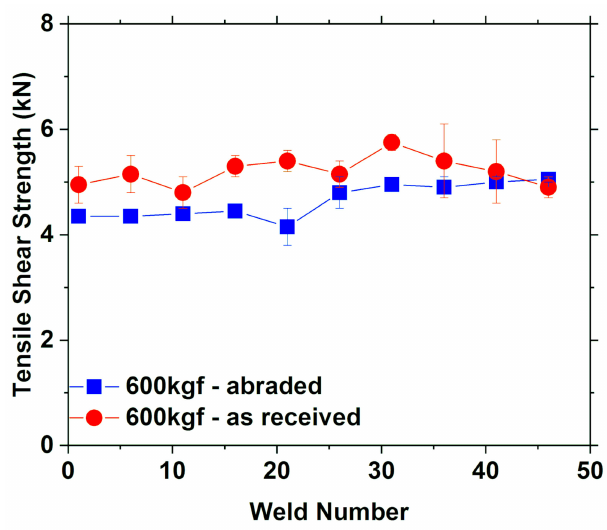
Figure 10. Measured tensile shear strength during continuous RSW under the electrode force of 600